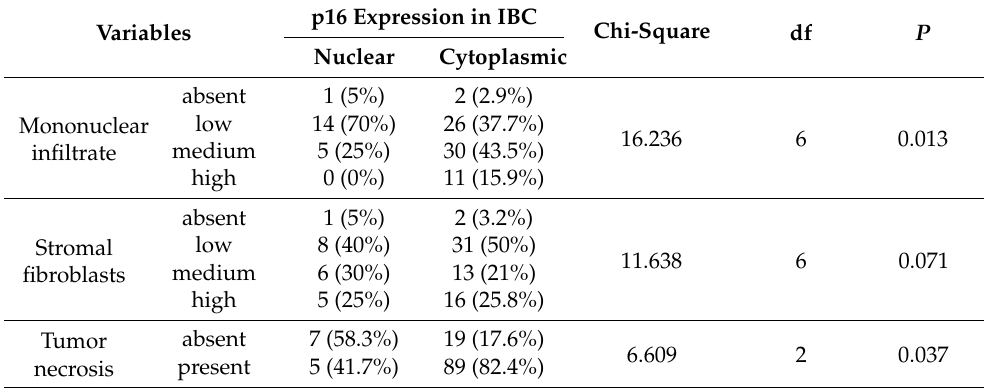
Table 5. Association of subcellular localization of p16 protein with clinicopathological characteristics of